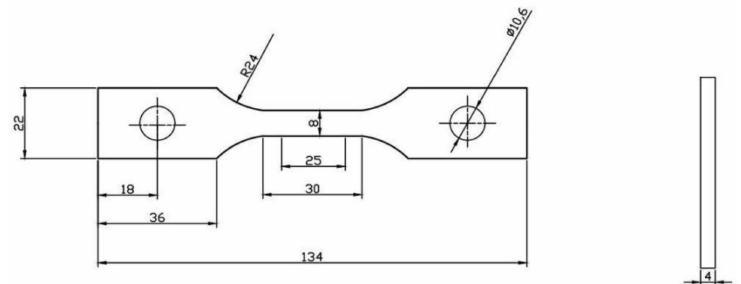
Figure 1. Q345 steel specimen size.